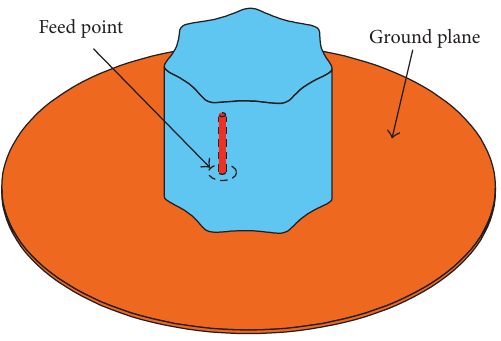
Figure 8: Probe-fed supershaped DRA